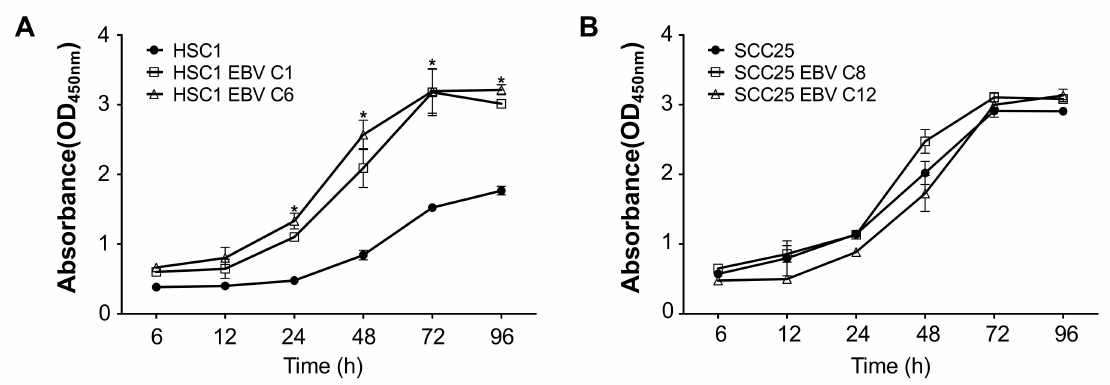
Figure 4. EBV infection induces cell proliferation in HSC1 cells, but not in SCC25 cells. Proliferation of HSC1 cells ( A ) and SCC25 cells ( B ) was examined by CCK-8. *: p <